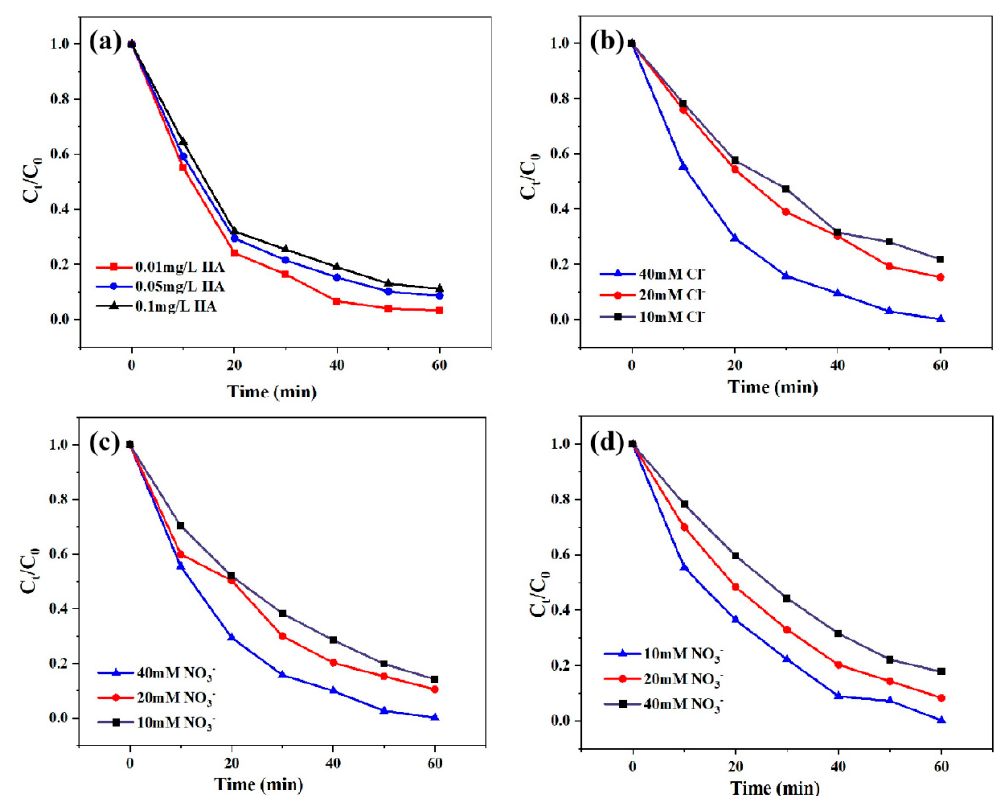
Figure 7. ( a ) Effect of humic acid on photocatalysis. ( b ) Cl-effect on photocatalysis. ( c ) NO 3 − effect on photocatalysis. ( d ) HCO 3 − effect on photocatalysis.